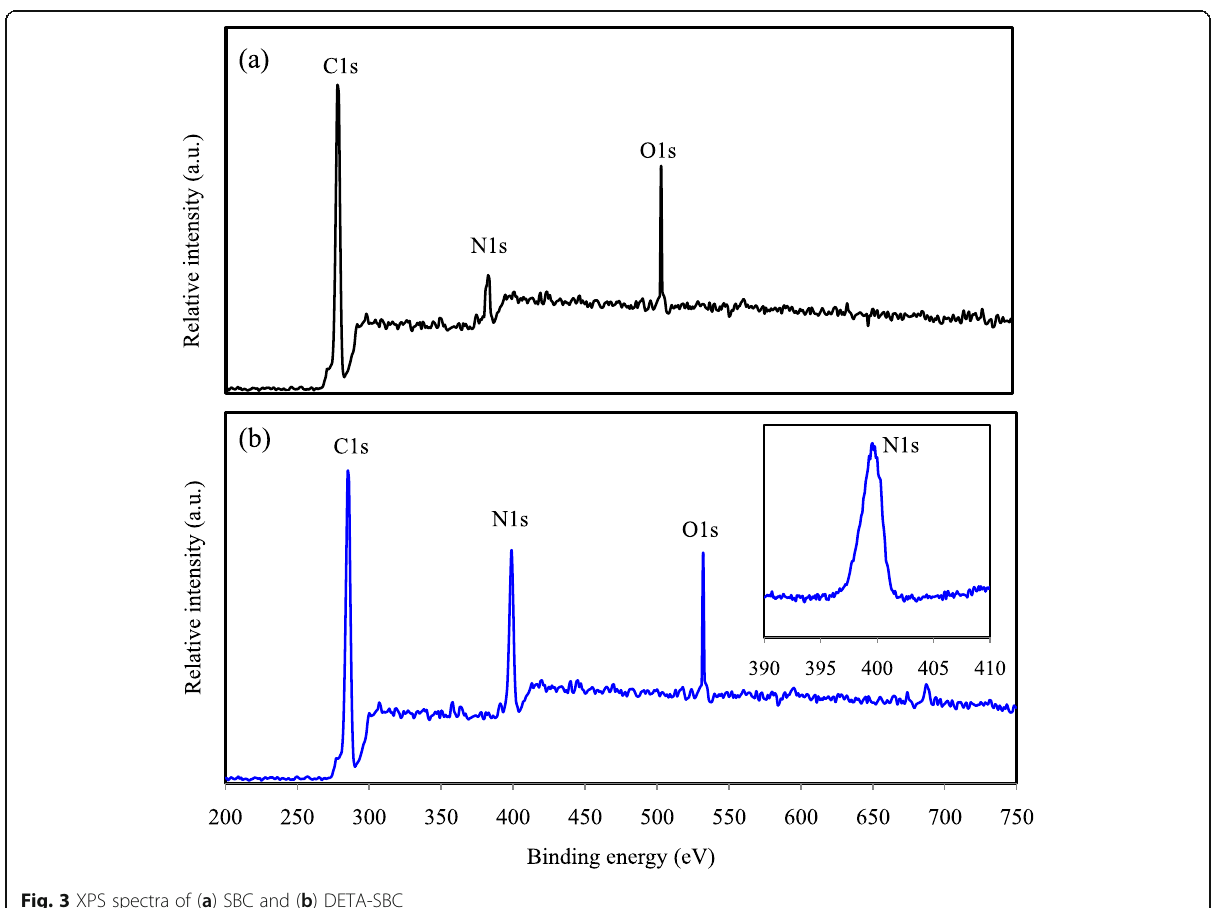
Fig. 3 XPS spectra of ( a ) SBC and ( b ) DETA-SBC